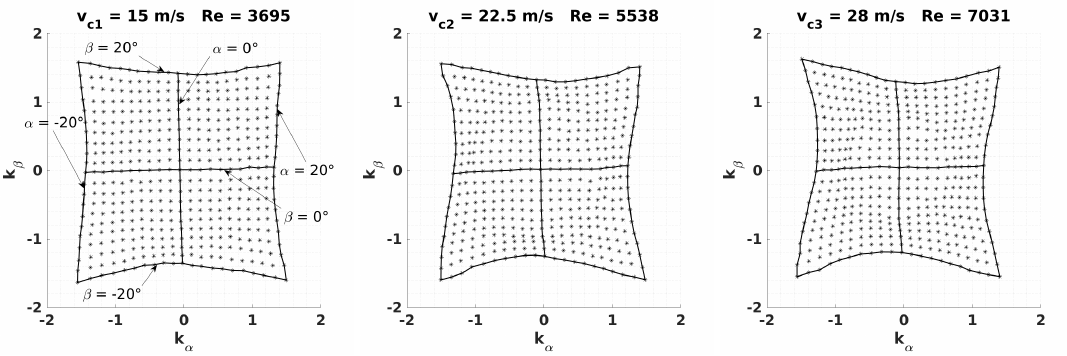
Figure 4. Calibration maps of k β over k α for − 20 ◦ ≤ α ≤ 20 ◦ and − 20 ◦ ≤ β ≤ 20 ◦ . The lines with constant α and β are only labelled in the map of v c 1 = 15 m s − 1 , but account for all calibration